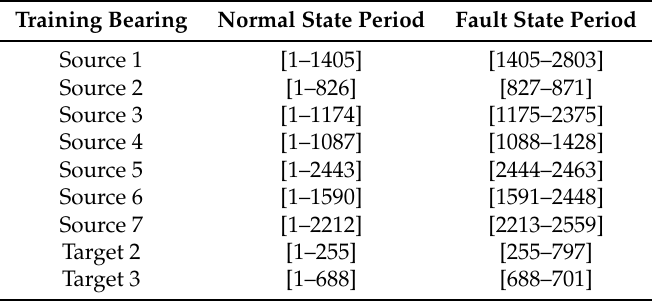
Table 3. Results of state assessment on training bearings with Target 1 chosen as test